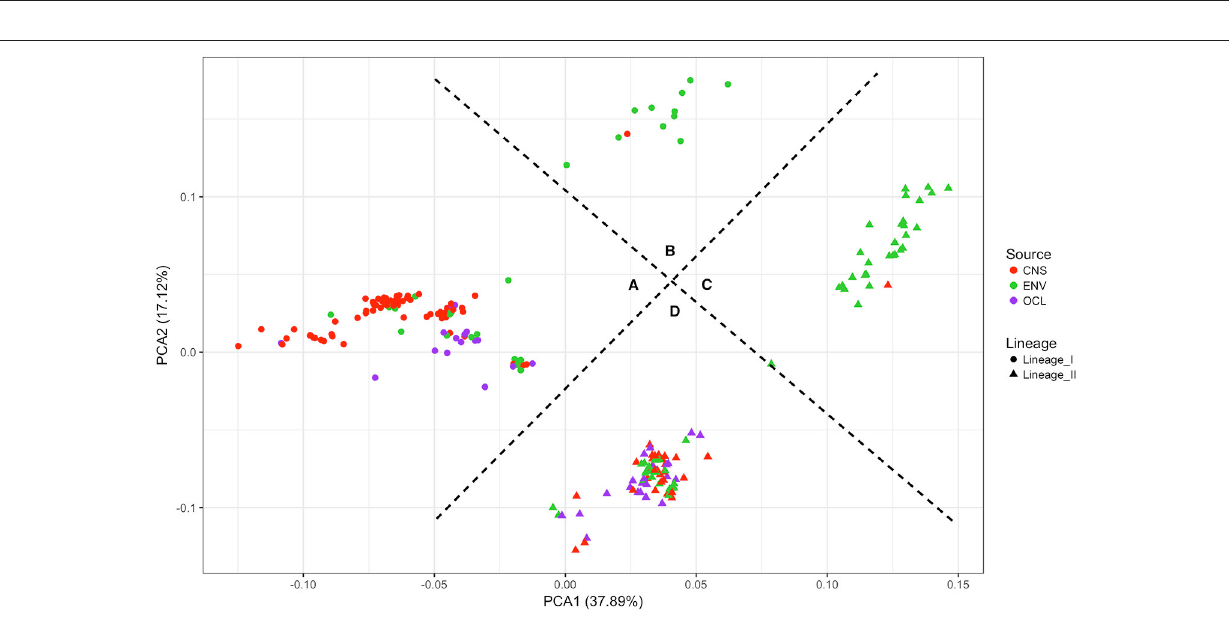
clinical or non-clinical, since is located at the middle of the two